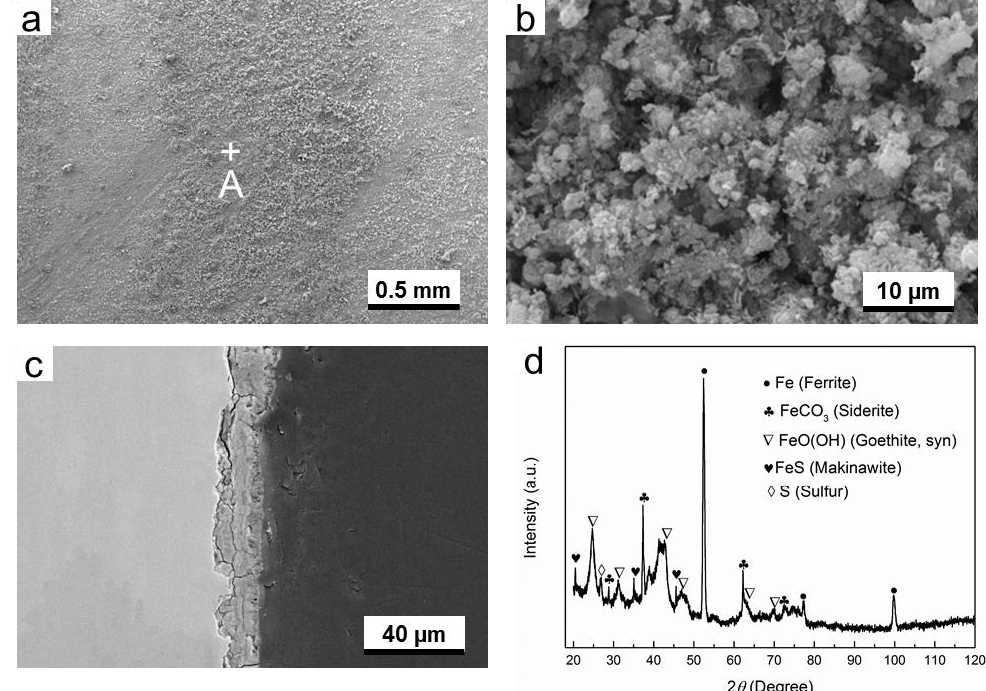
Figure 8. The characterization of corrosion products on G20 steel in gas phase in O 2 -H 2 S-coexisting environment: ( a ) SEM image of the surface of corrosion products, ( b ) the higher magnification of region A marked in ( a ), ( c ) corrosion-sectional image of corrosion product layer, and ( d ) XRD pattern of the corrosion products.